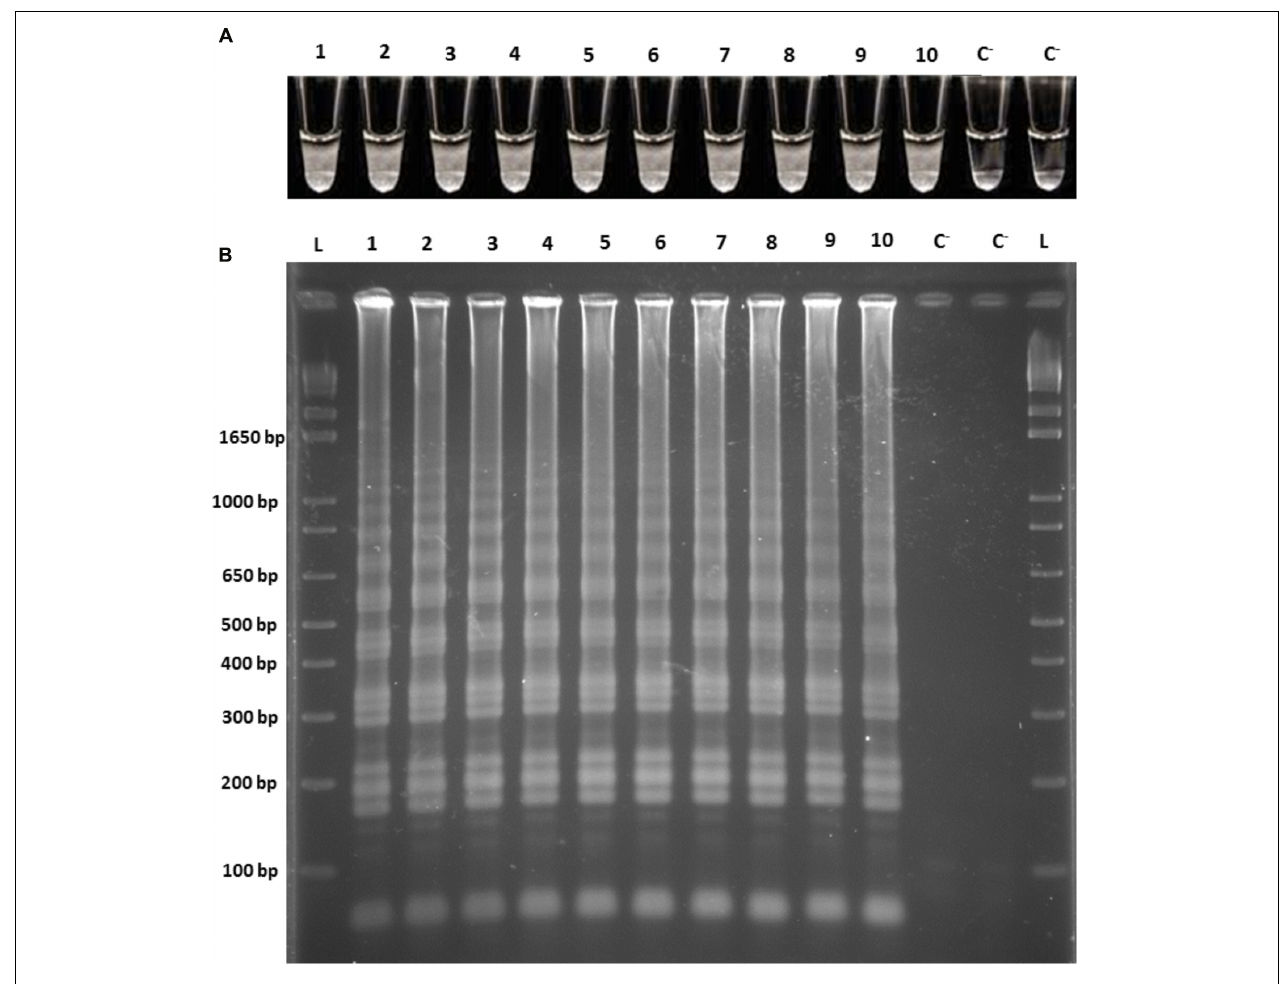
FIGURE 2 | LAMP amplifications from the O. oeni cell suspensions from the culture medium, white grape must, red grape must, white wine, and red wine. (A) Direct turbidity observation; (B) Agarose gel electrophoresis of the amplified products. 1, 2, culture medium; 3, 4, white grape must; 5, 6, red grape must; 7, 8, white wine; 9, 10, red wine; C − , negative control; L, 1 kb plus DNA Ladder